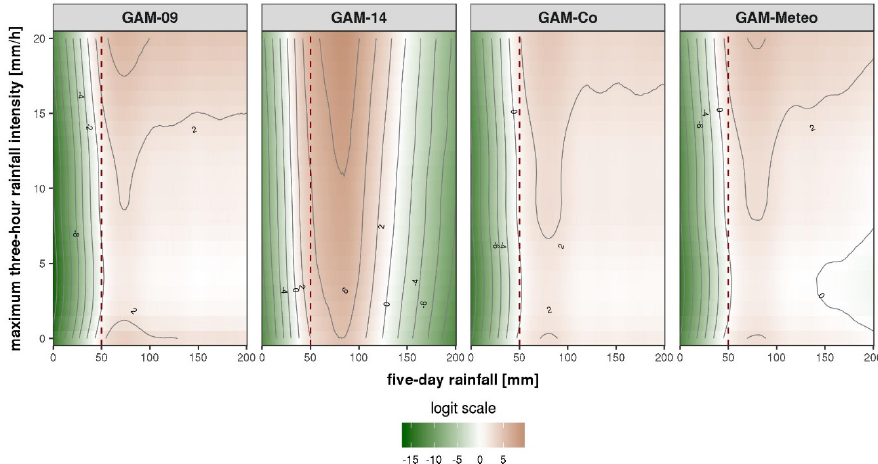
Figure A3. Relationship between landslide occurrence and metrological variables as pair of predictor variables. The relationship on the linear predictor scale (logit scale, centered) were extracted from all SpCV models and averaged (contour lines). Red dashed line: Estimated critical rainfall thresholds for five-day rainfall. Geosciences 2020 , 10 , x FOR PEER REVIEW